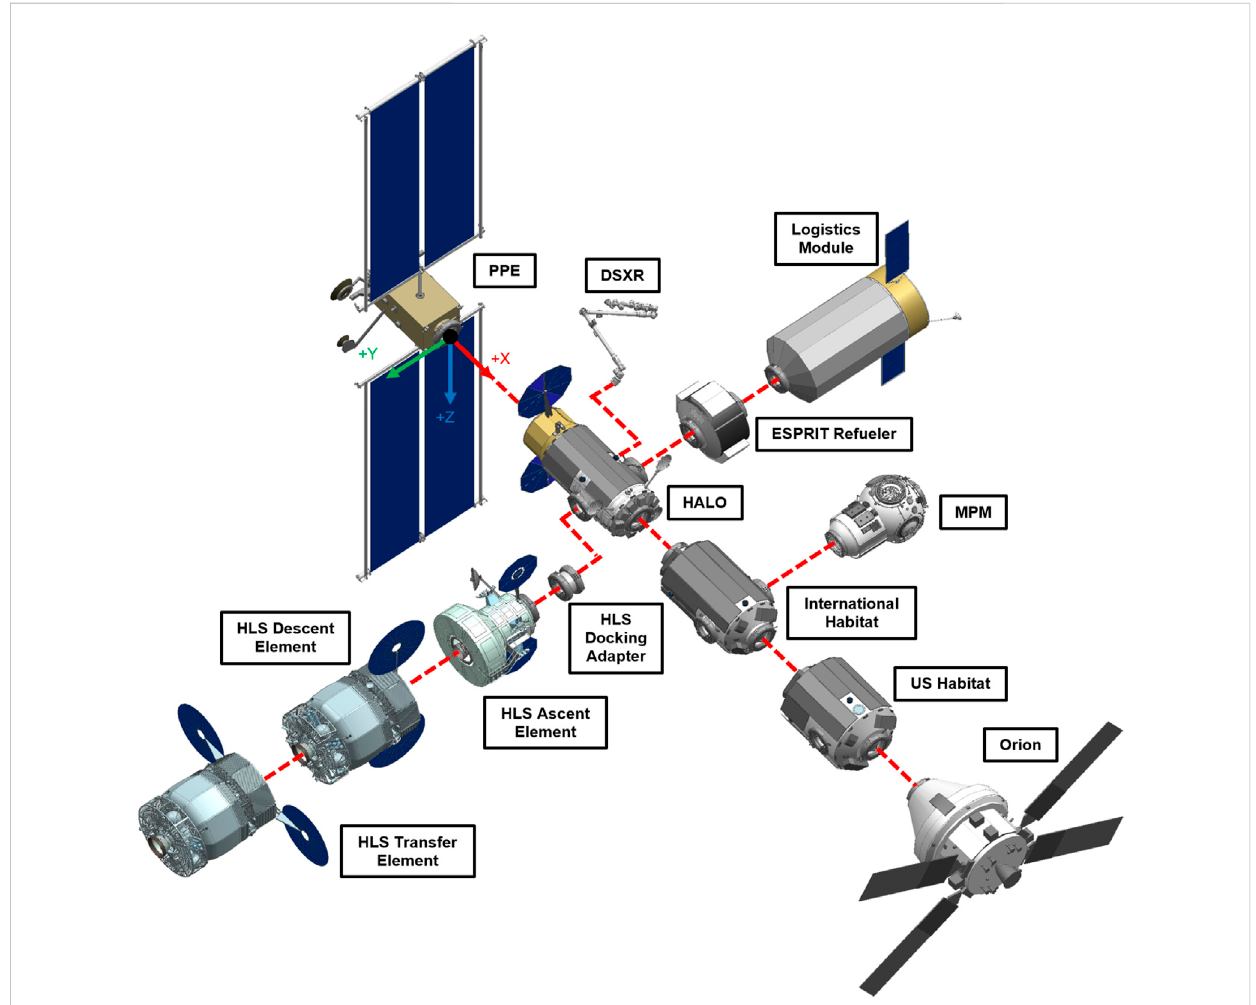
FIGURE 12 Gateway con fi guration. PPE: Power and PropulsionElement; HLS: Human Landing System; HALO: Habitation and Logistics Outpost (Credit: